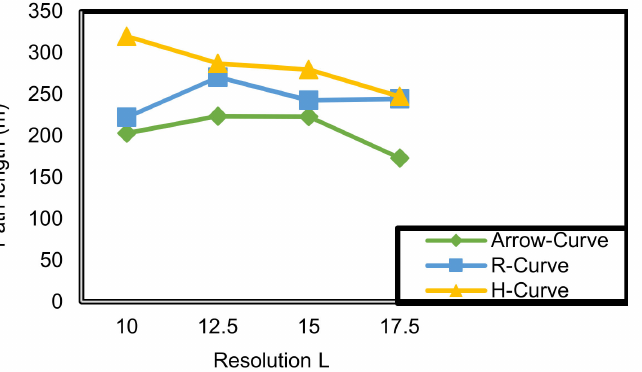
Figure 15. Path length (PL) corresponding to resolution (L) in Arrow-Curve model, R-Curve path model, and